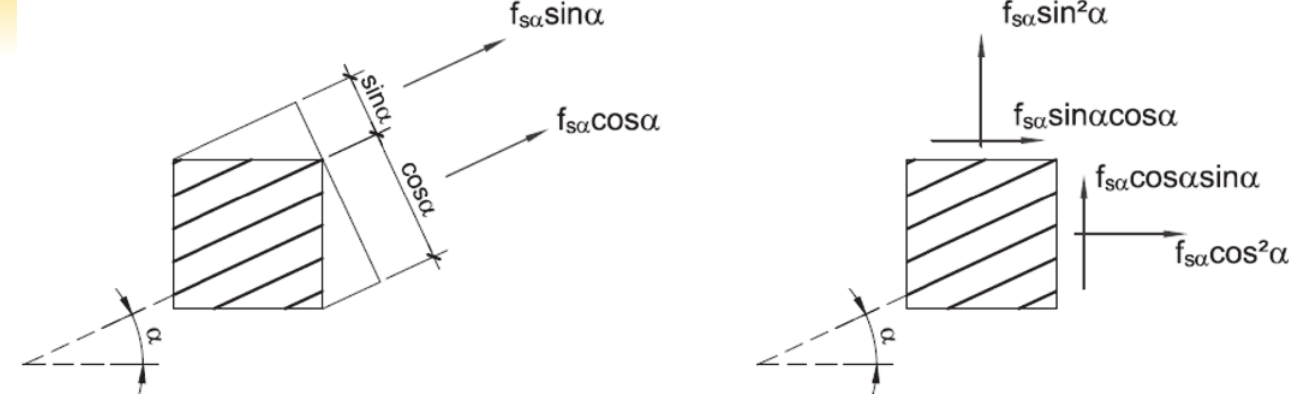
Figure 4 Force components of fs